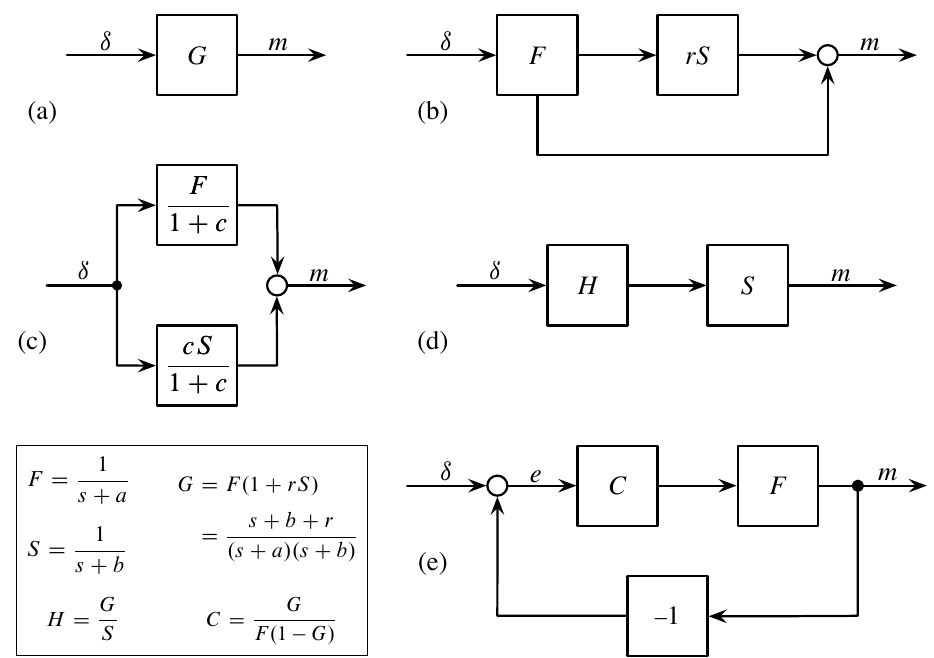
Figure 2. Alternative models that yield identical biexponential decay. The text describes each panel. The parameters can be matched to the generic model in Equation (1). with r = c ( a − b ) / ( 1 + c )